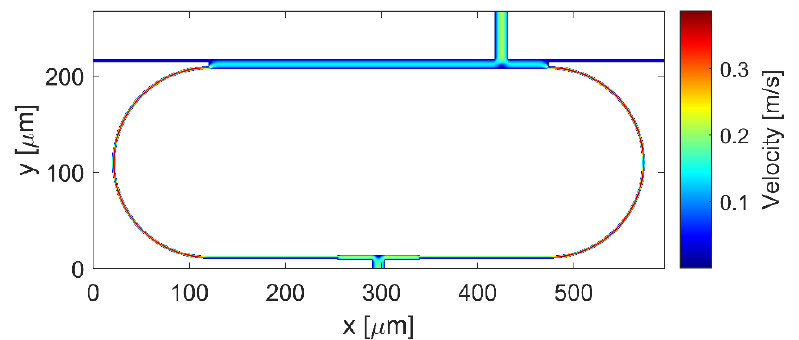
Figure 7. Three-dimensional steady-state flow profile of the optimized ring configuration.